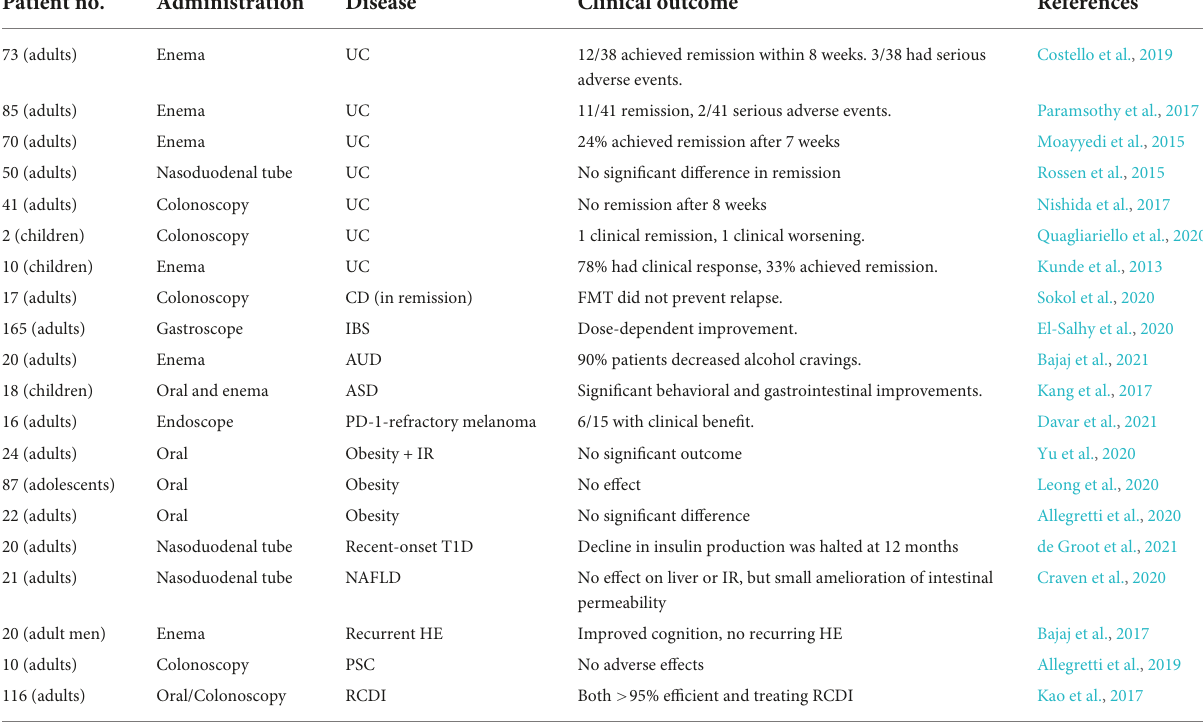
TABLE 3 Overview of different FMT clinical trials and their outcome. Patient